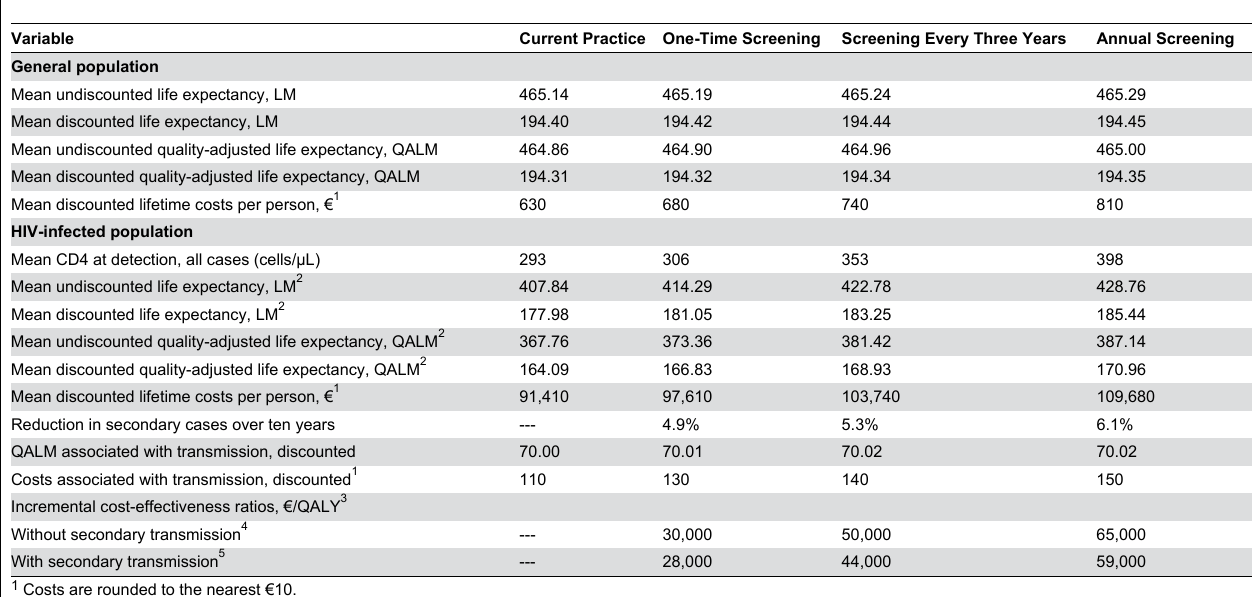
Table 2. Base Case: Routine HIV Screening in Portuguese National